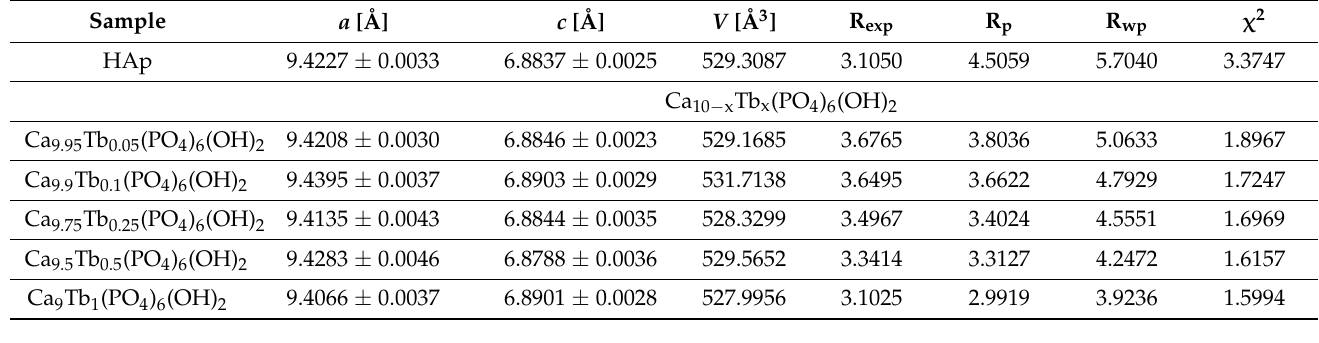
Table 3. Unit cell parameters a , c , V and agreement indices for hydroxyapatite HAp andCa 10 − x Tb x (PO 4 ) 6 (OH) 2 (with x = 0.05, 0.1, 0.25, 0.5 and 1).